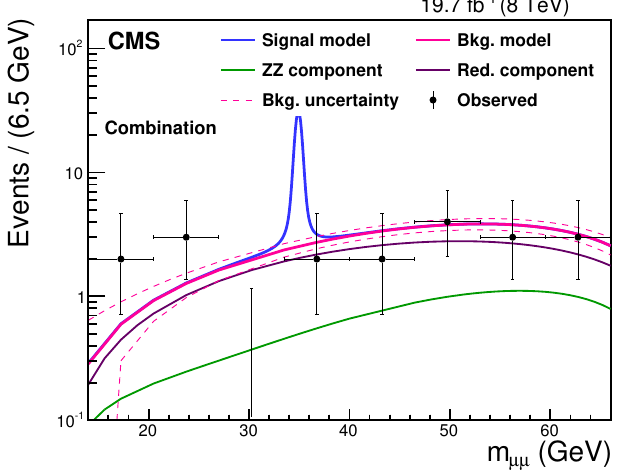
(cid:28) (cid:0) , (cid:22) + (cid:22) (cid:0) (cid:28) (cid:6) (cid:28) (cid:7) , (cid:22) + (cid:22) (cid:0) (cid:28) (cid:6) (cid:28) h (cid:7) , (cid:22) + (cid:22) (cid:0) (cid:28) (cid:6) (cid:28) h (cid:7) , and e e e (cid:22) e (cid:22)